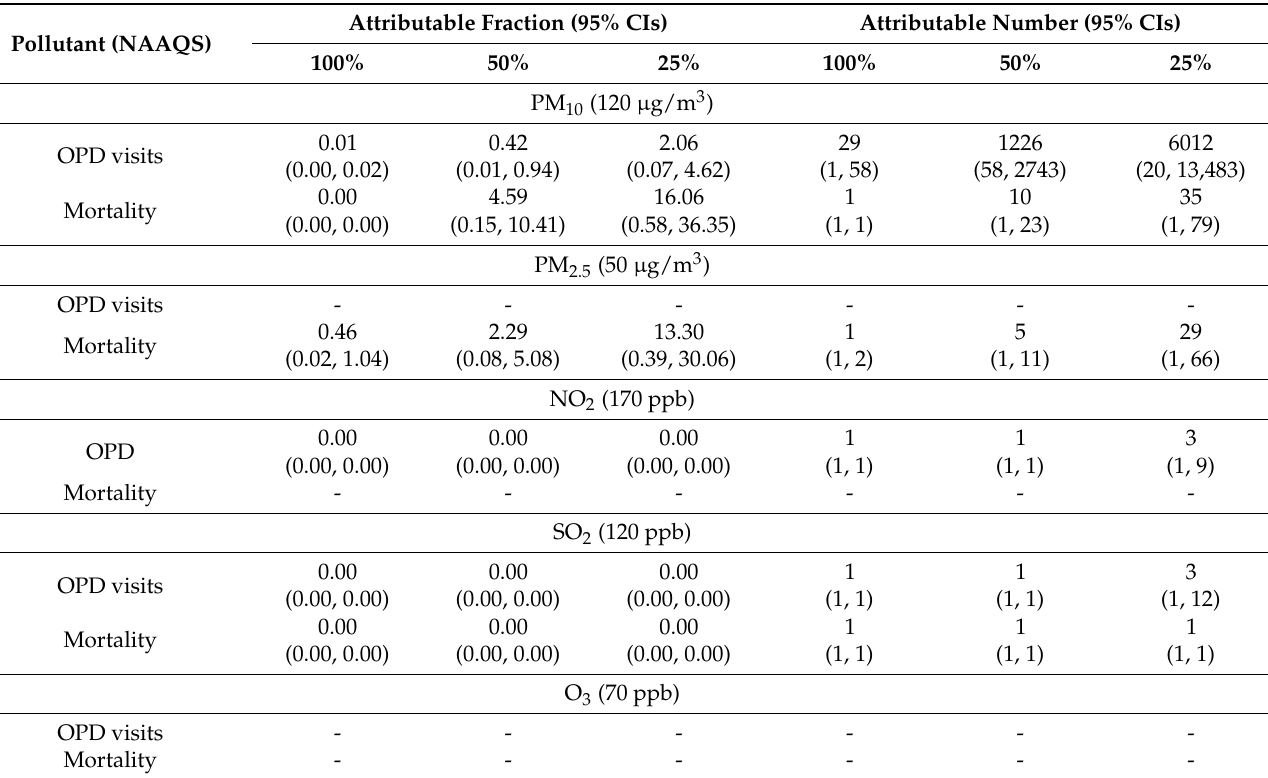
Table 11. Attributable fractions and attributable numbers of outpatient department (OPD) visits